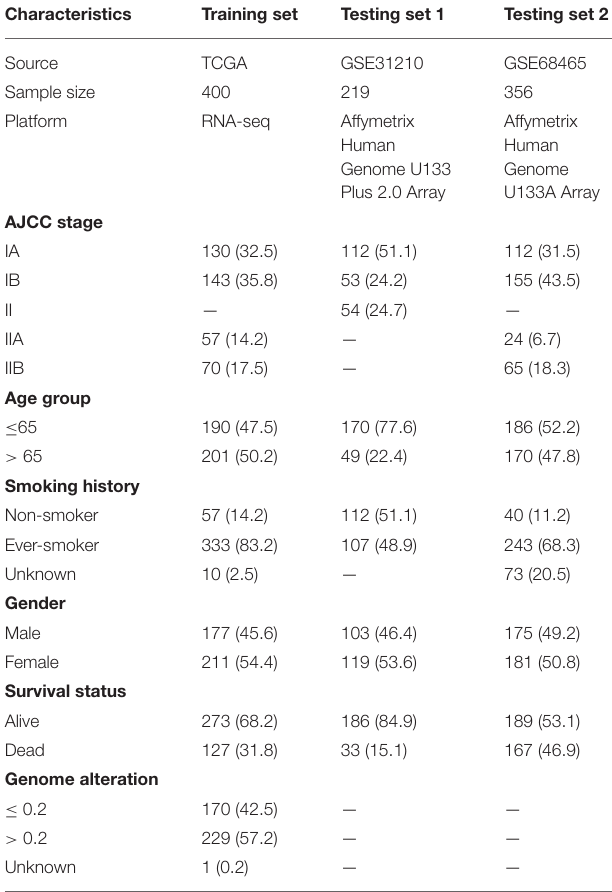
TABLE 1 | Detailed patient clinical